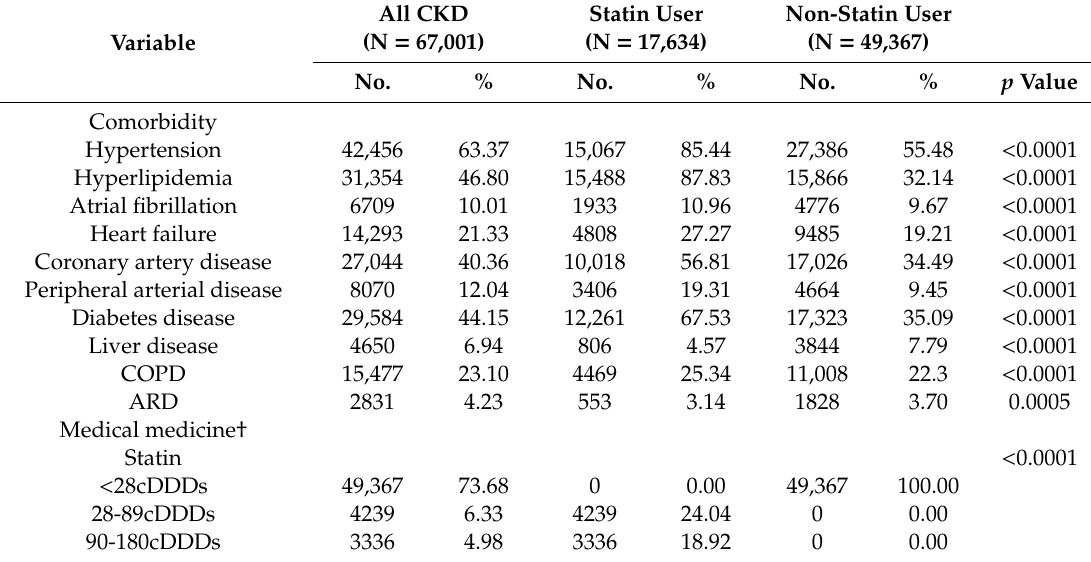
Table 2. Clinical characteristics of chronic kidney disease patients in